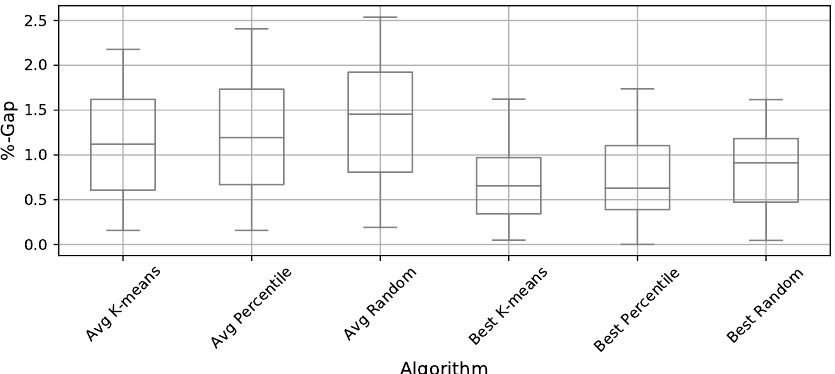
Figure 4. Average and best values box plots for 250 instance and cuckoo search algorithm results of Random, Percentile, and K-means